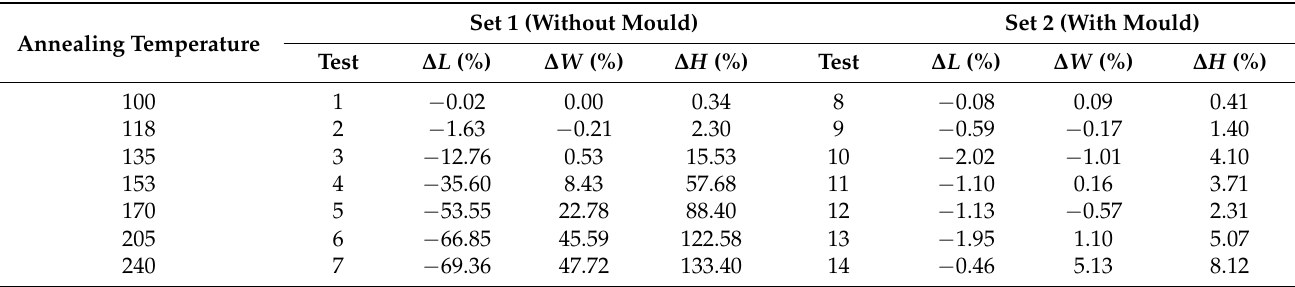
Table 4. ABS average dimensional changes after thermal treatment.